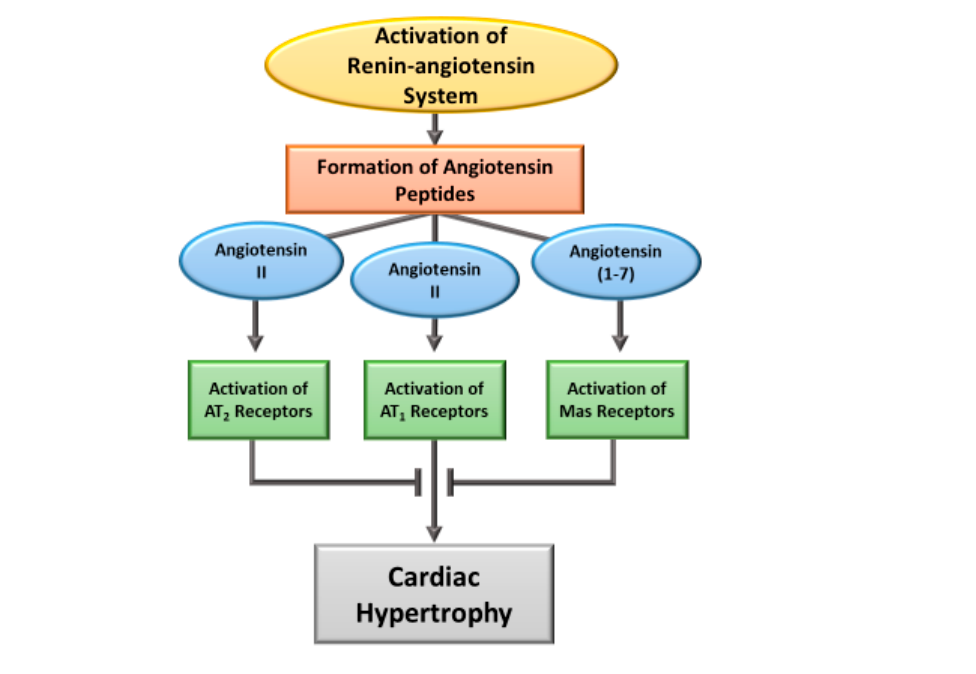
Figure 1. A schematic representation for the involvement of different angiotensin peptides such as Ang II and Ang (1-7) as well as their receptors for the development of cardiac hypertrophy upon the activation of renin-angiotensin system. It is pointed out that although other angiotensin peptides such as Ang III, Ang IV and Ang (1-9) are also formed during the activation of renin-angiotensin system, their role and receptor mechanisms are not fully understood.